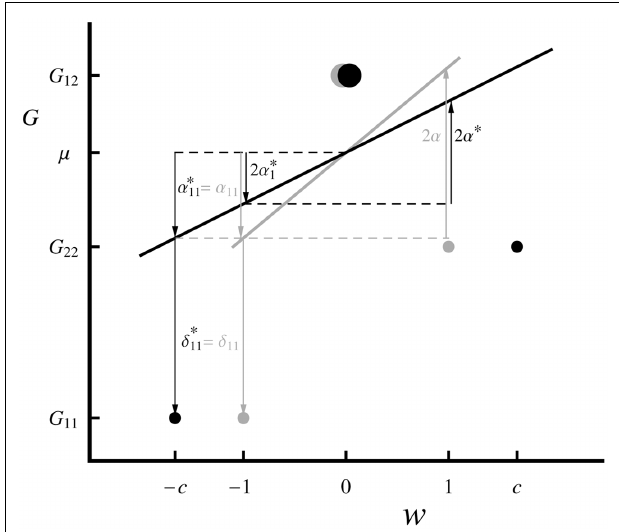
FIGURE 1 | Graphical interpretation of the decomposition of the genotypic values (5) through the statistical excess (in black) and the statistical (in gray) formulations of NOIA for one locus with two alleles. For simplicity, a case with equal allele frequencies ( p 1 = p 2 = 1/2) is shown.The specific genotypic values (circles; G 11 = 1, G 12 = 3, G 22 = 2) displaying overdominance and a fixation index ( F =− 2/5) have been chosen for facilitating the visualization of the parameters of interest.The size of the circles represents the frequency of the genotypes. Horizontal dashed lines emphasize coincident arrow edges, the upper one corresponding to the population mean phenotype, μ = 2.55.The regression independent variable of the statistical formulation is the gene content, whereas the one of the statistical excess formulation is scaled by c = 1/(1 + F ) = 5/3 and it works as an effective gene content. For both cases, the independent variable, w , is rescaled by its expectation as shown in Table 1